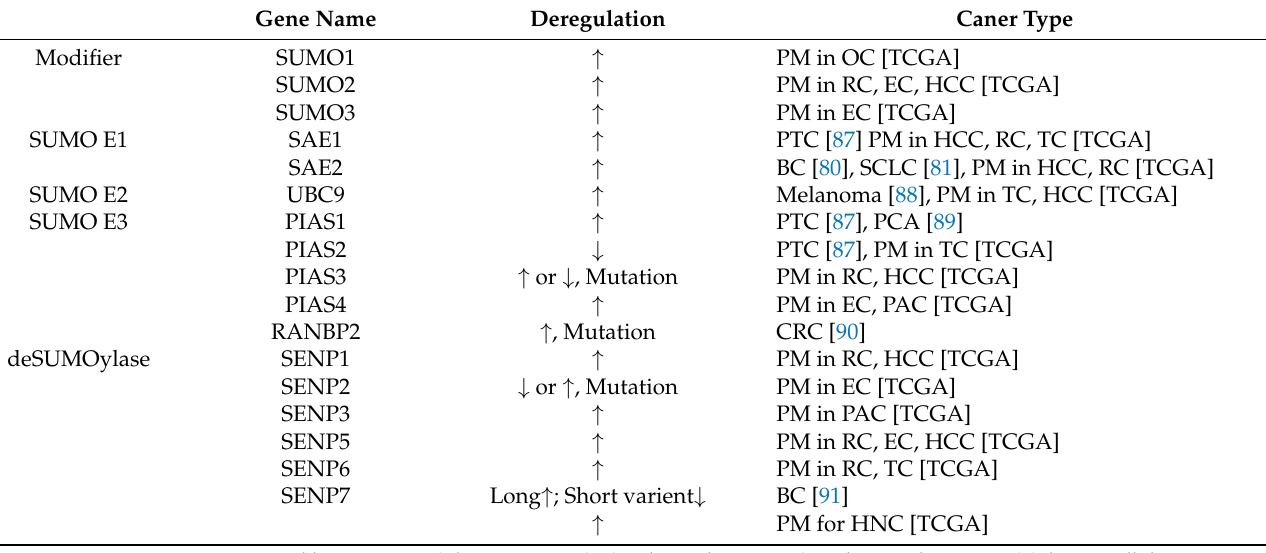
Table 5. Examples of SUMOylation components associated with